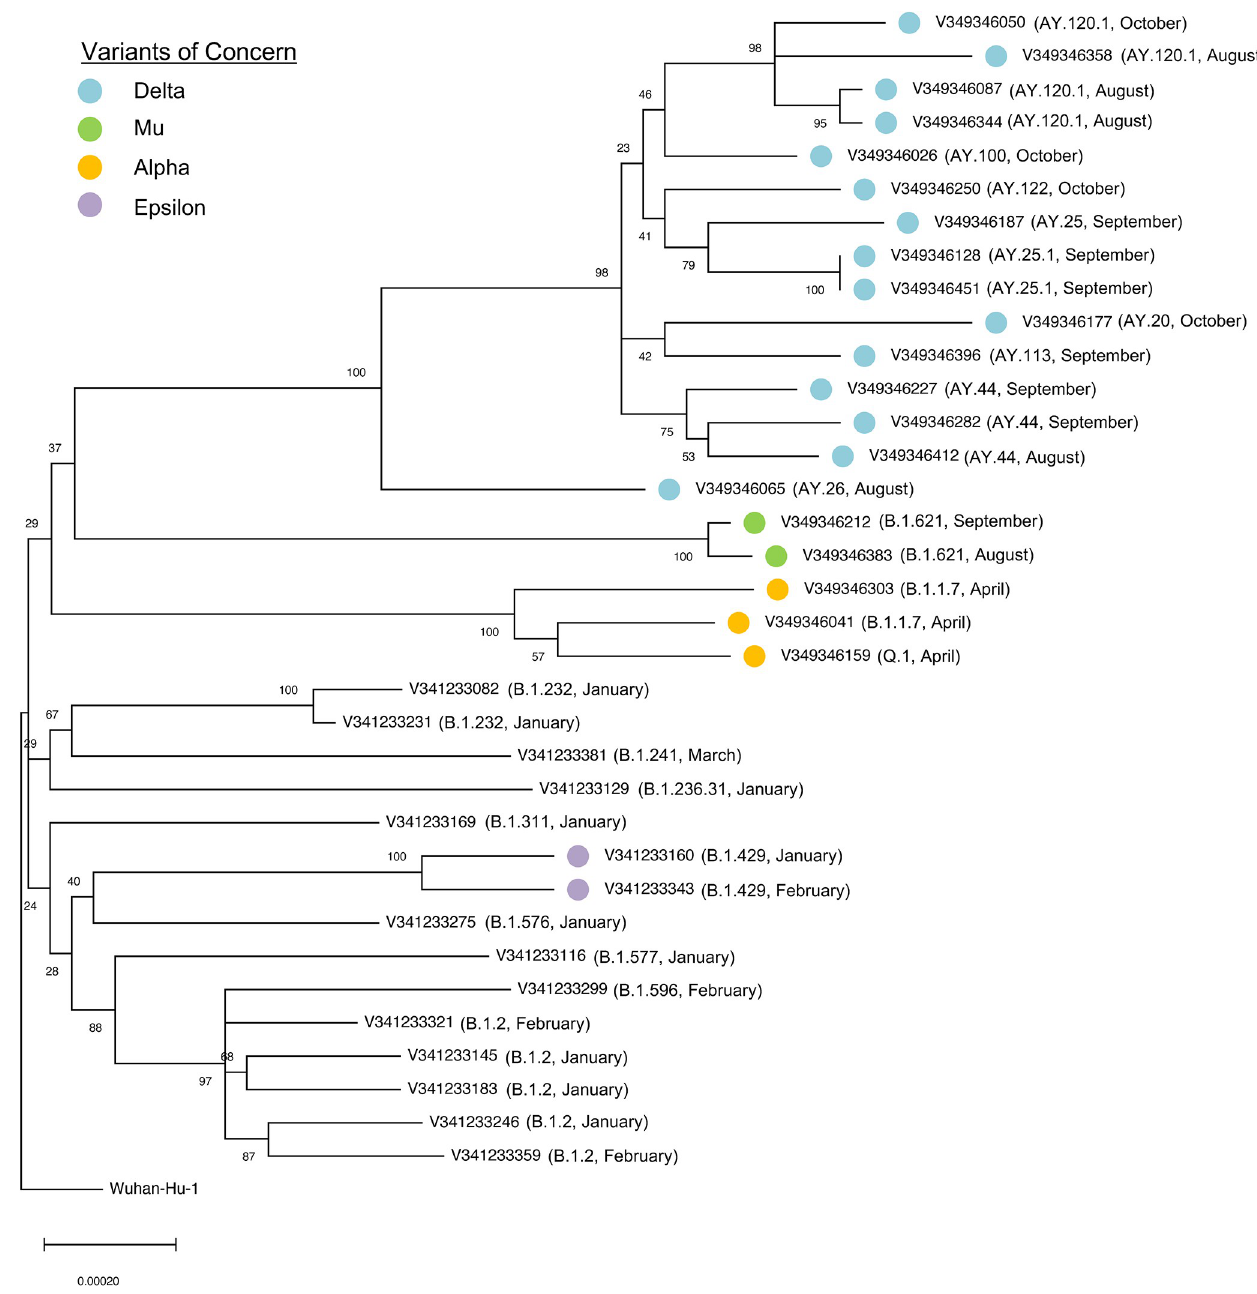
Fig 6. Phylogeny of samples in dataset. Maximum-likelihood tree depicting evolutionary relationship between all samples. Numbers at branch points indicate the percentage of trees in which the associated taxa clustered together during 500 bootstrap iterations. Colored circles indicate variants of concern or variants being